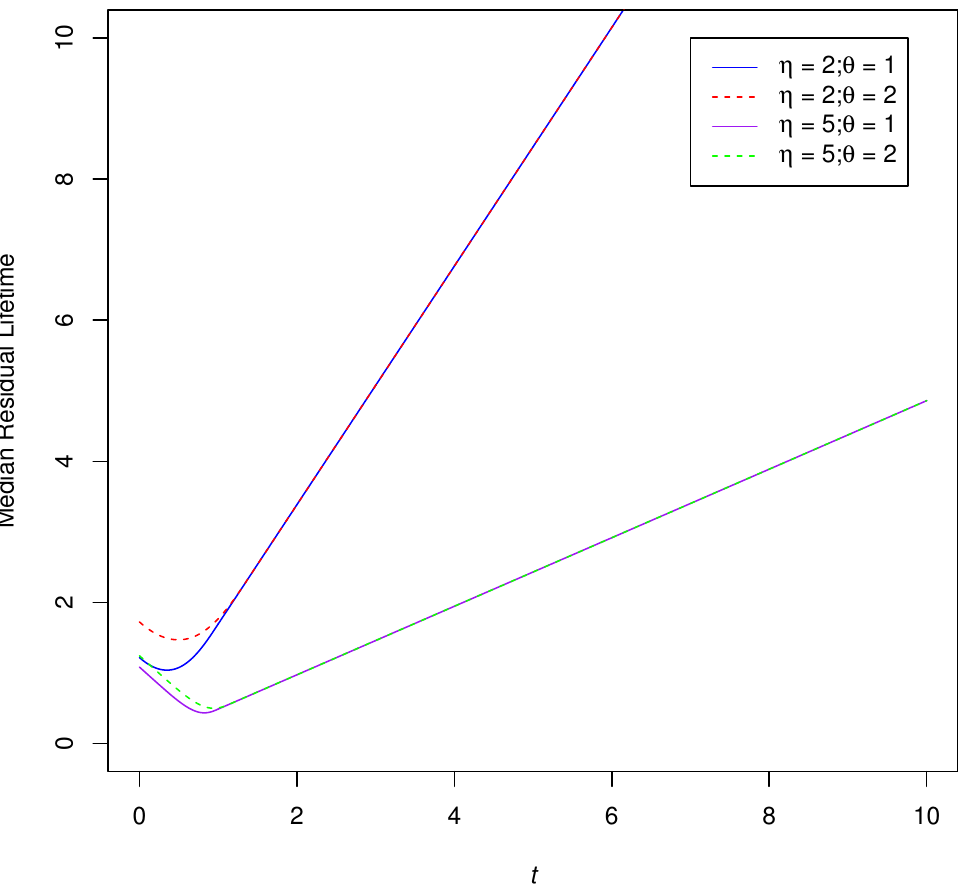
Figure 5. The median residual lifetime function plot of EEP distribution with different